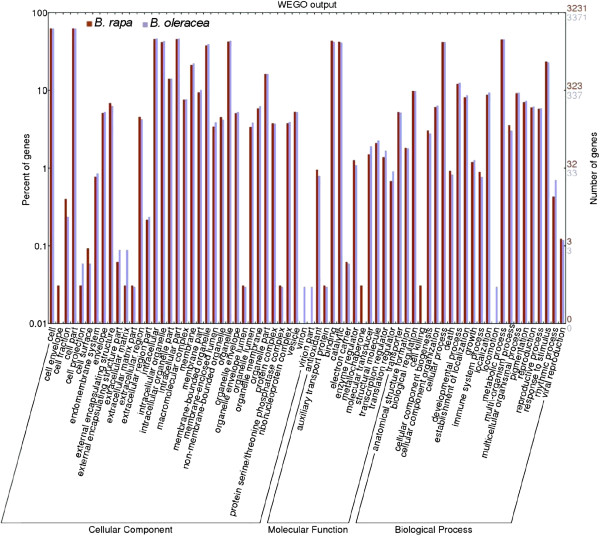
Histogram showing Gene Ontology functional analysis of DEGs. The frequency of GO terms was analyzed using GO Slim Assignment. The y-axis and x-axis indicate the names of clusters and the ratio of each cluster, respectively.